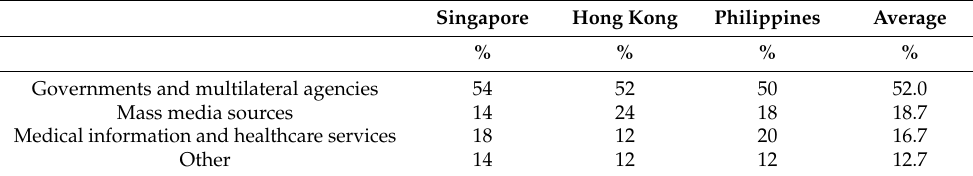
Table 2. Proportion of URLs by source category for each location.